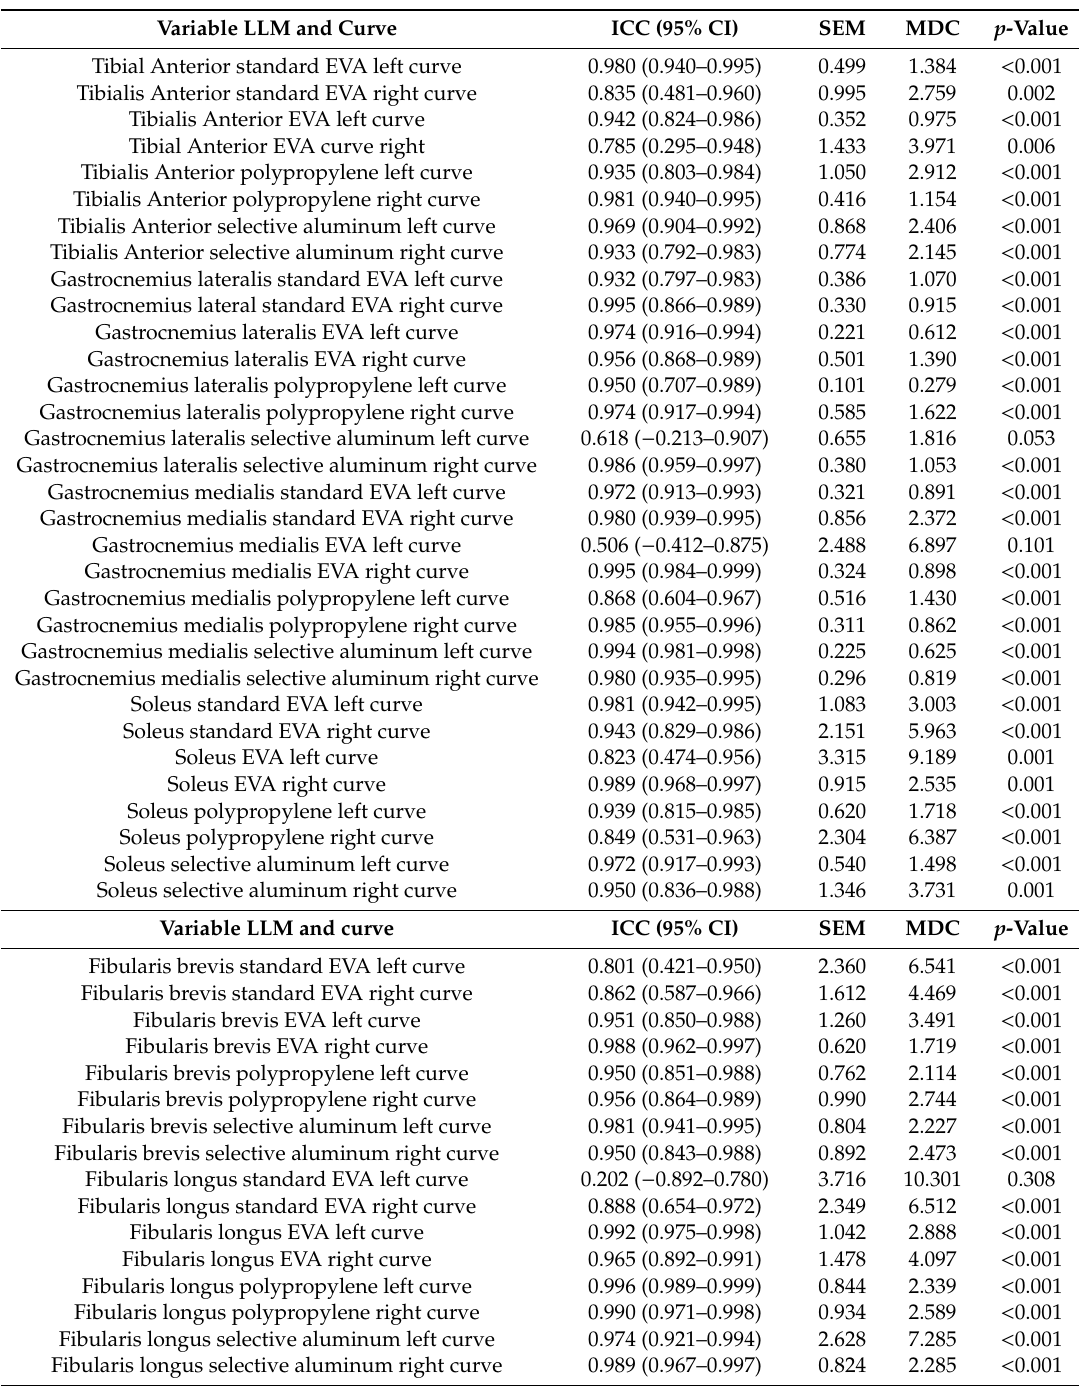
Table 3. Intraclass correlation coe ffi cients, standard error of measurement and minimal detectable change for electromyography (EMG) activity patterns of the lower limb muscles by types of customized foot insoles for left and right curves in the